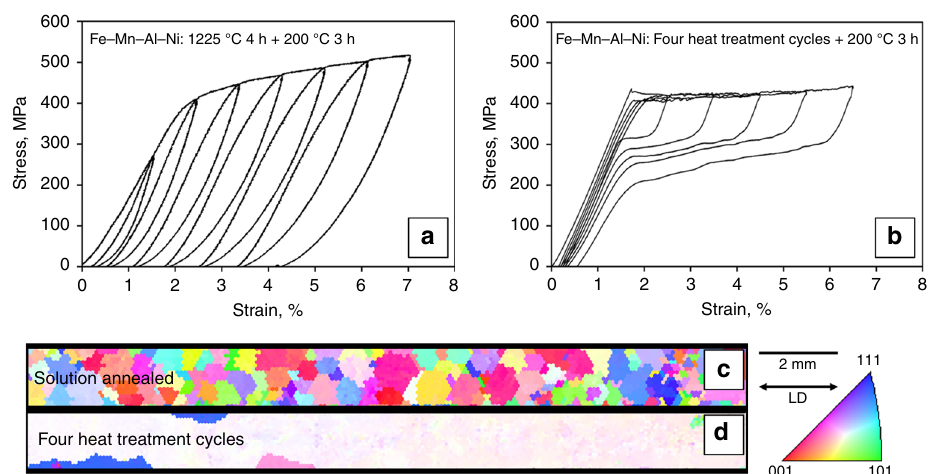
Fig. 1 Pseudoelastic response of Fe – Mn – Al – Ni tension samples with different grain sizes. Stress – strain curves of Fe – Mn – Al – Ni after a solution treatment at 1225 °C for 4 h in a and after a cyclic heat treatment for four times in b . c , d show the corresponding electron-backscatter diffraction orientation maps of the samples plotted for the loading direction (LD). The colors correspond to the crystal directions given in the stereographic triangle. Details on the cyclic heat treatment procedure are shown in Supplementary Fig.